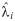
Synthetic daily cases generated by simulating the Hawkes-type count process and the estimated reproduction number.(A) Rapid increase followed by a slow decrease. (B) Increase followed by a rapid decrease, and then an increase. (C) Slow increase followed by a decrease, and then another large increase. In the upper panel plotting the number of daily cases (purple line), the rate estimated by the state-space method λ^i is also plotted (blue line). In the lower panel, the reproduction number R^i estimated with the state-space method is plotted in reference to the true reproduction number Ri (purple line). The blue solid line and the shaded area represent the median and 95% range of the posterior distribution, respectively. The reproduction numbers estimated by Wallinga and Teunis (WT: orange line) and by Cori et al. (EpiEstim: green line) are also plotted for reference.